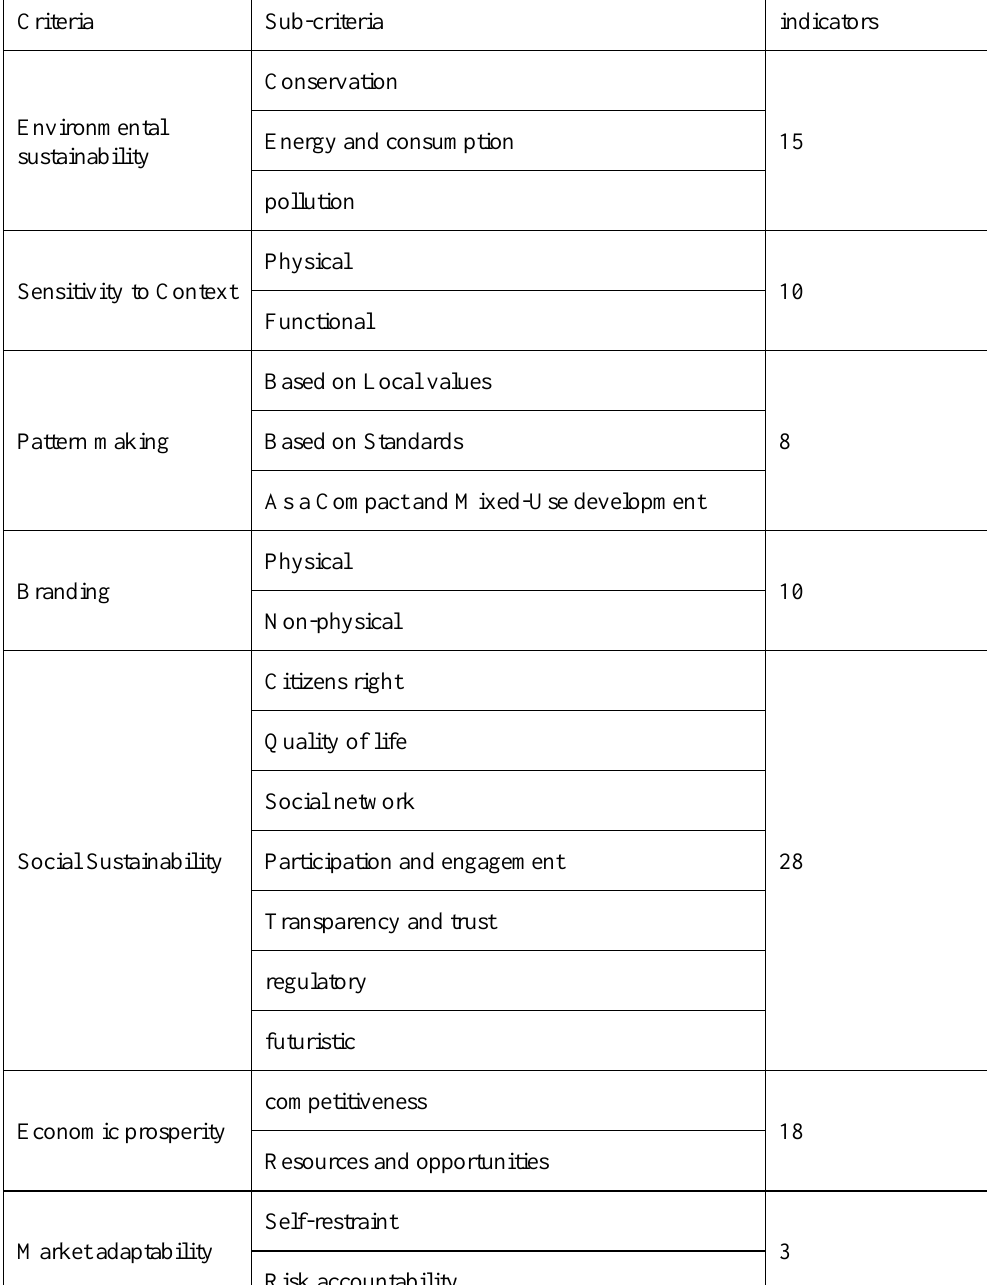
Table 2. Criteria and indicators for assessing the intensity and quality of stimulation by urban